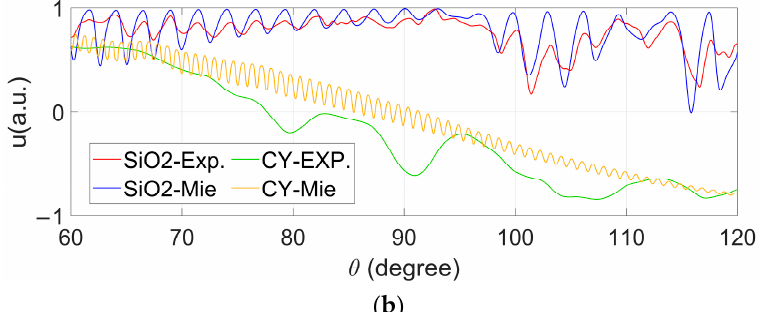
Figure 12. Polarization parameters q ( a ) and u ( b ). Experiment results of SiO 2 (red) and CY (green); Mie theory simulation results of SiO 2 (blue) and CY (yellow).